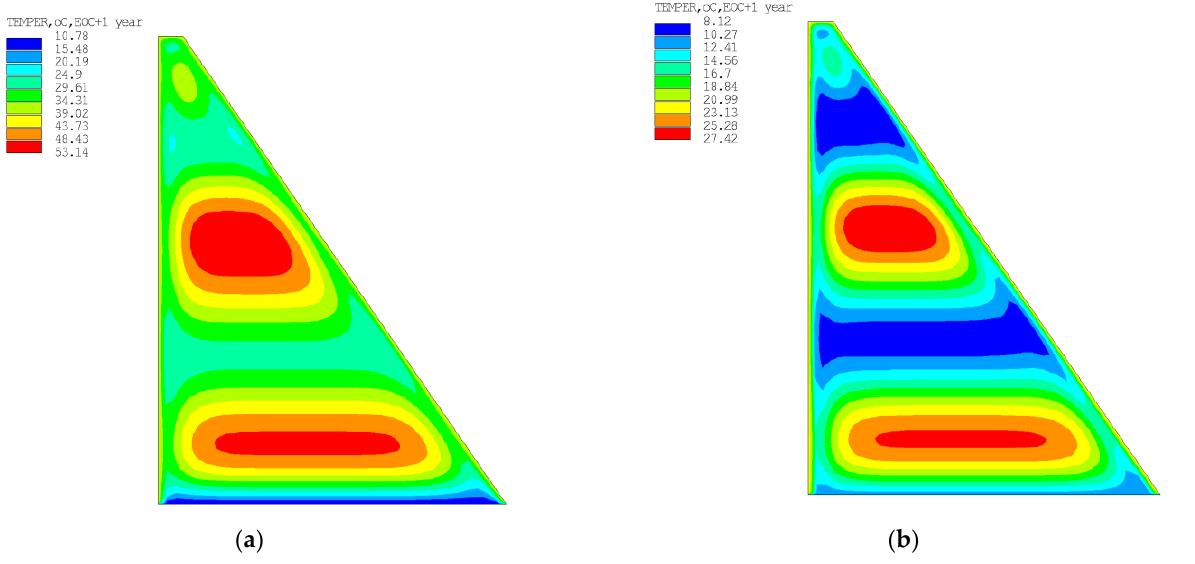
Figure 9. Calculation results for maximum temperature in concrete mass: ( a ) The least favorable calculation case; ( b ) The most favorable calculation case.